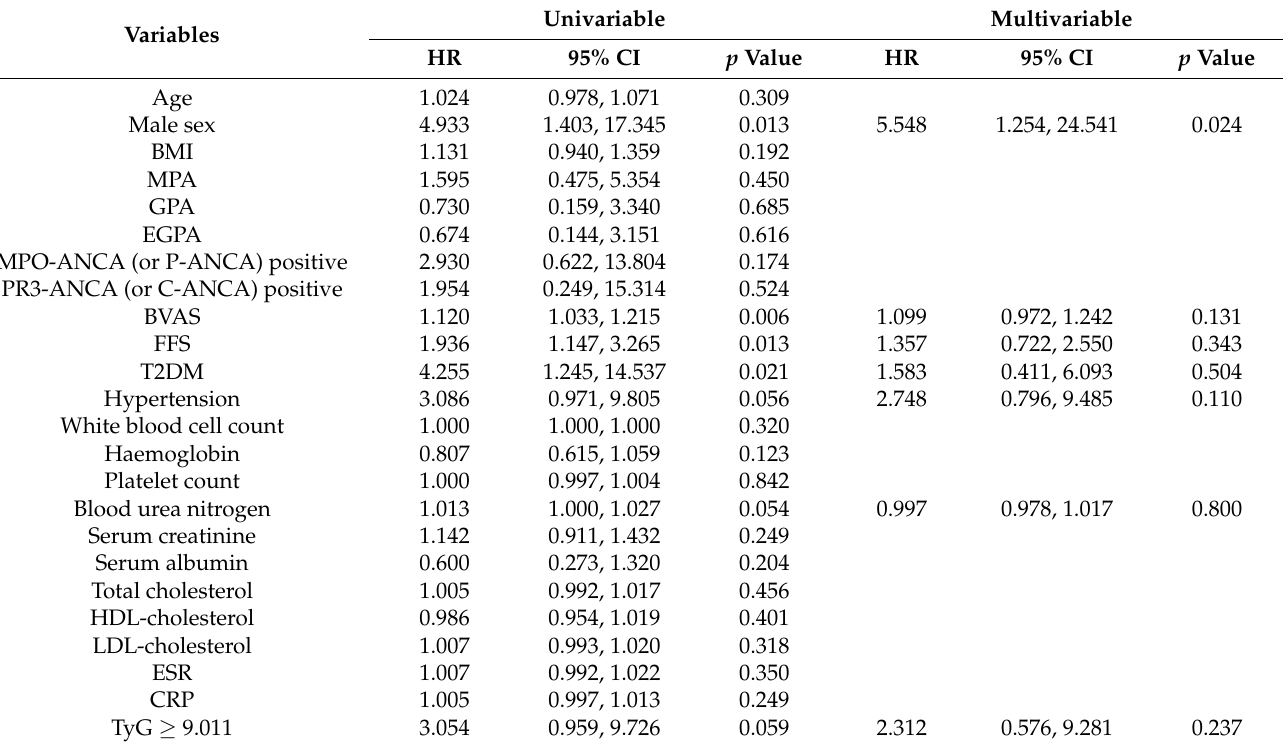
Table 2. Cox hazards model analysis of variables at AAV diagnosis for ACS during